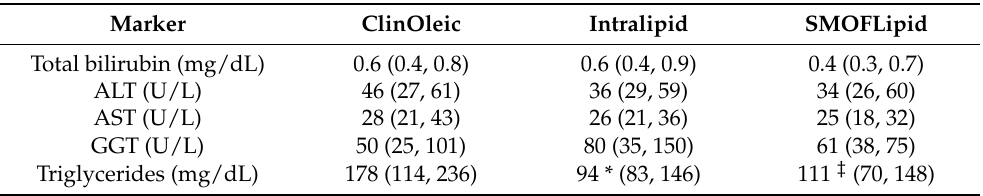
Table 5. Plasma liver function markers and triglycerides in patients receiving different lipid